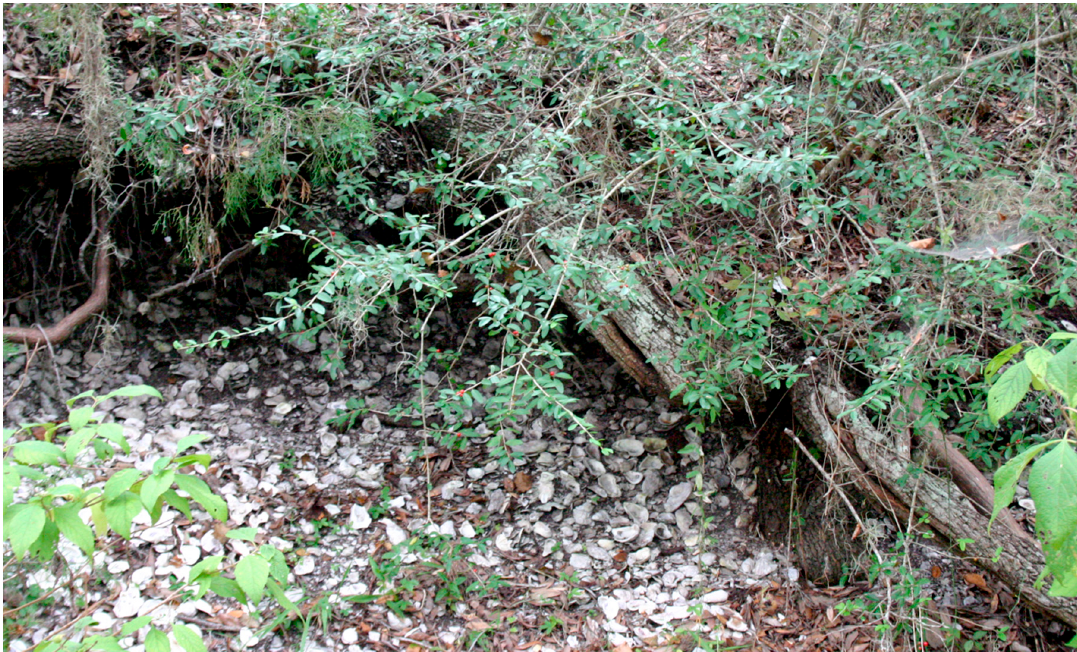
Figure 7. Shells visible under plants growing on Shell Mound. Photograph courtesy of the author.